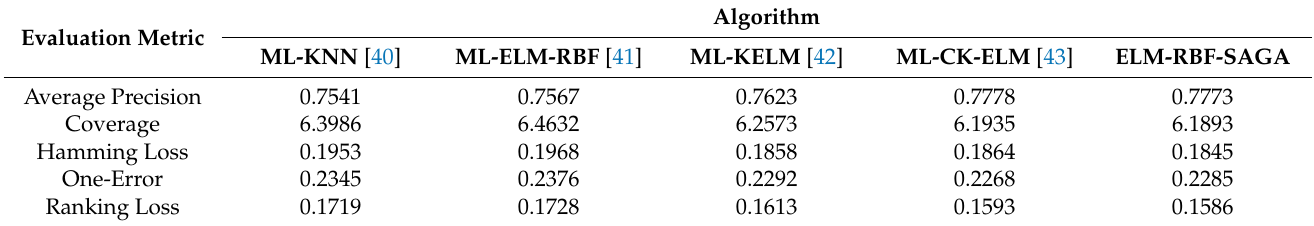
Table 6. Performance of different models in the yeast dataset.